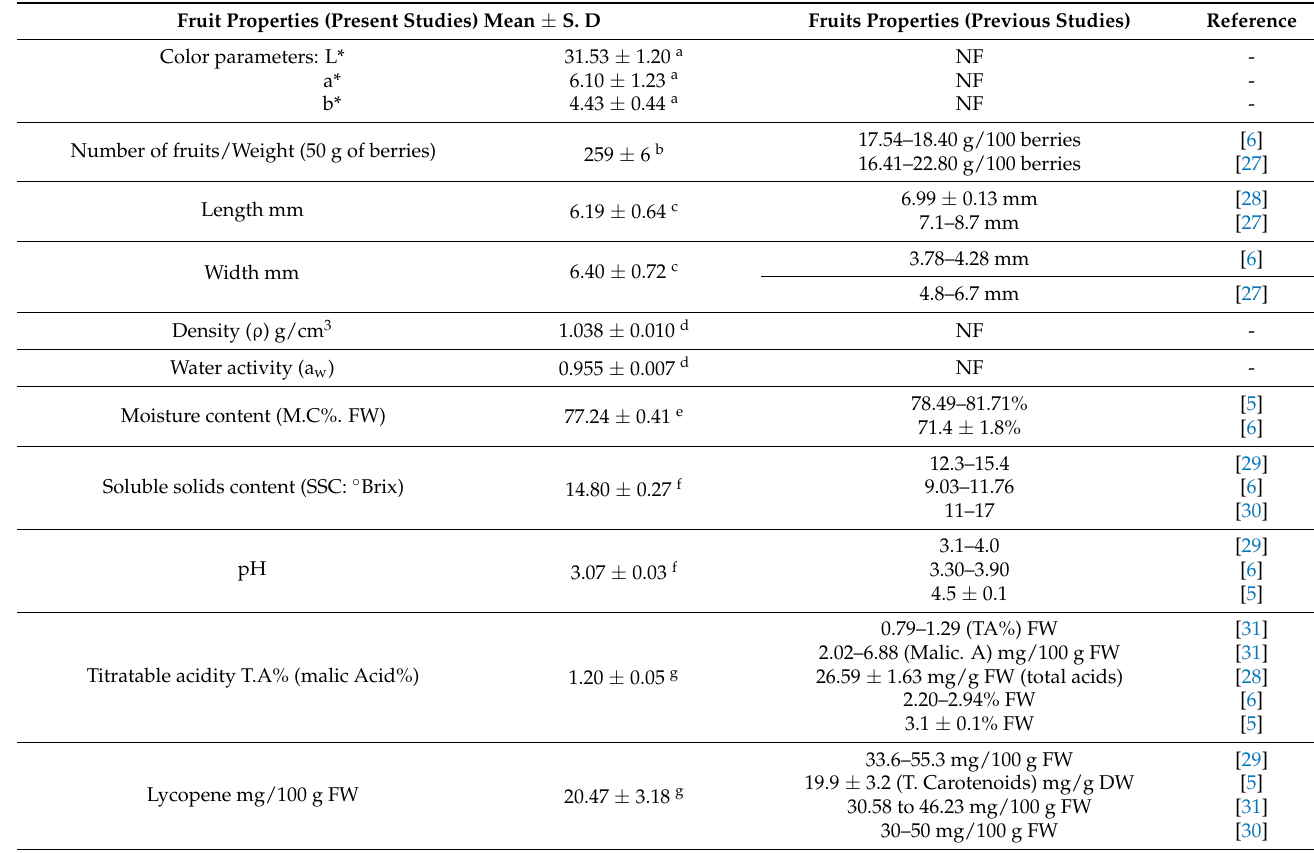
Table 1. Physicochemical properties and antioxidant activity of autumn olive berries (in the present study and from the